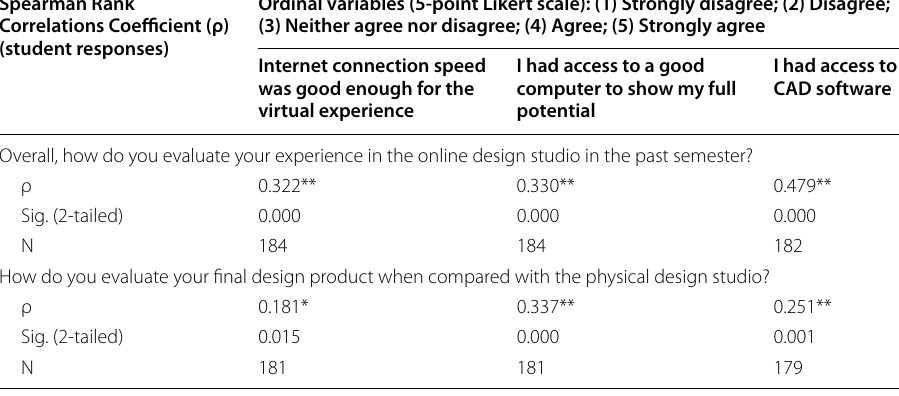
Table 1 The Spearman rank correlation coefficient (ρ) between the overall experience of VDS and potential external factors